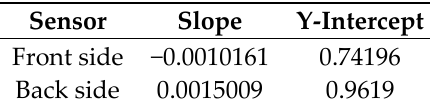
Table 1. Linear regression